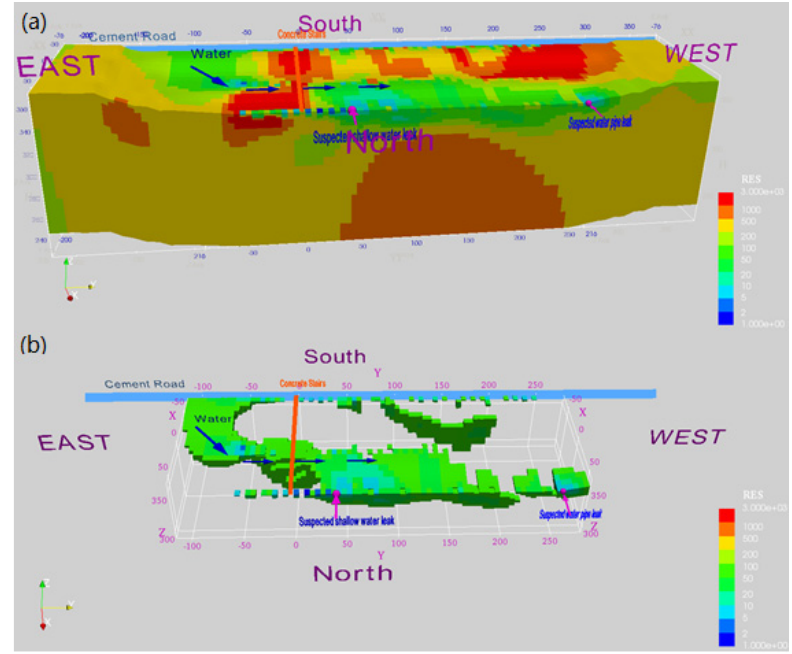
Figure 4. Pseudo − 3D resistivity data inversion results. ( a ) resistivity cube, ( b ) low resistivity path.